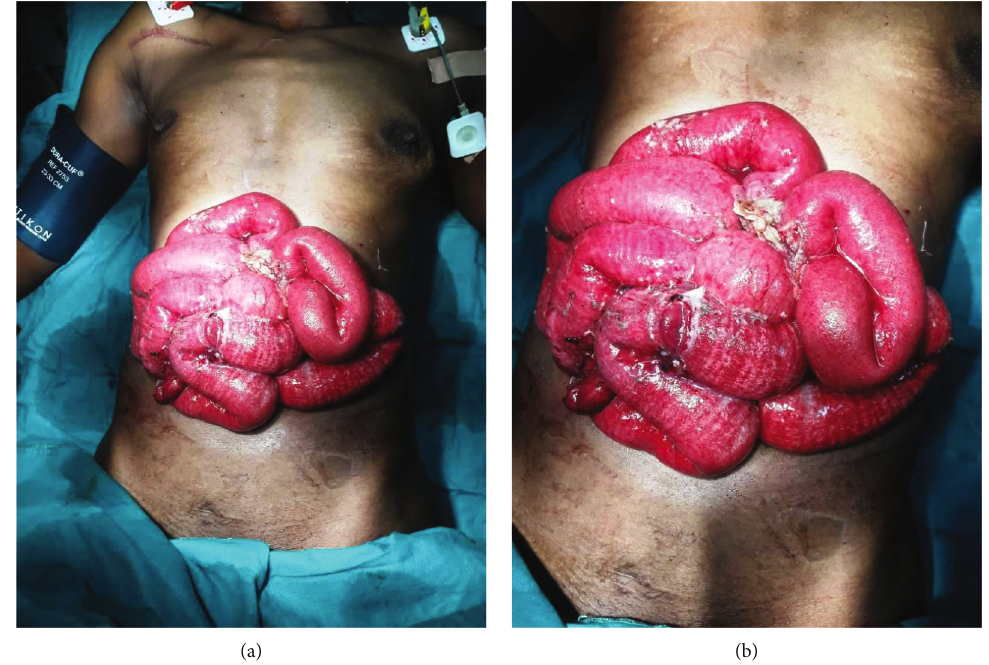
Figure 3: (a and b) Eviscerated small bowels with traumatic perforation in case three patient from knife stab